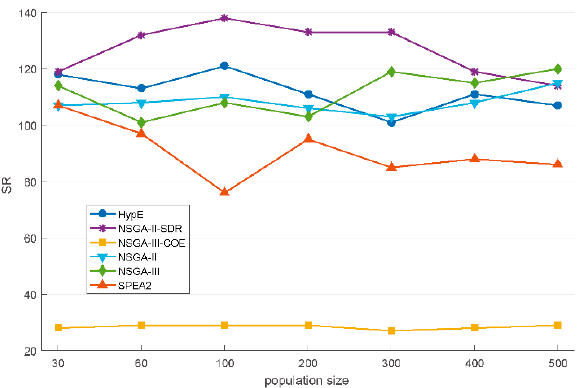
Figure 12. The impact of population size on the performance of the NSGA-III-COE and other multi- objective evolutionary algorithms (MOEAs) on 27 benchmark instances. The figure shows the sum of rankings of 27 instances obtained by each algorithm when the population size is 30, 60, 100, 200, 300, 400, and 500.